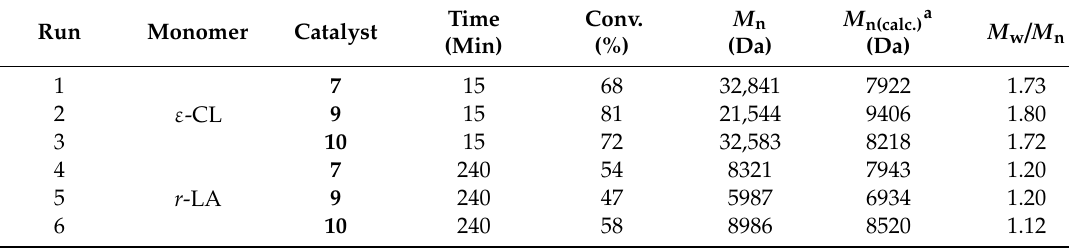
Table 2. ROP of ε -CL and r -LA catalyzed by 7 , 9 and 10 [37].